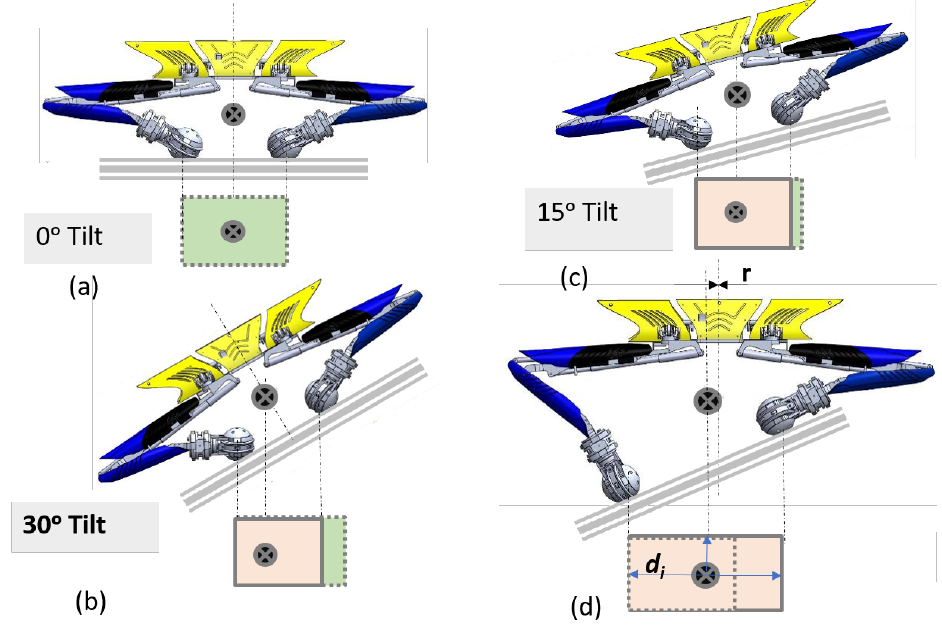
Figure 8. The variation of the CG (centre of gravity) location of the platform on ( a ) flat surface, ( b ) trunk parallel to an inclined plane of 15 degree tilt, ( c ) trunk parallel to an inclined plane of 30 degree tilt, and ( d ) trunk in horizontal position on an inclined plane of 30 degree tilt. On a horizontal plane (zero degree tilt), when all the legs are of the same length and the trunk is perfectly horizontal, the centre of gravity is exactly at the centre of the support polygon. As we move the platform on the inclined plane from 0 to 30 degrees with the trunk body parallel to the plane, the area of the support polygon gradually reduces, and